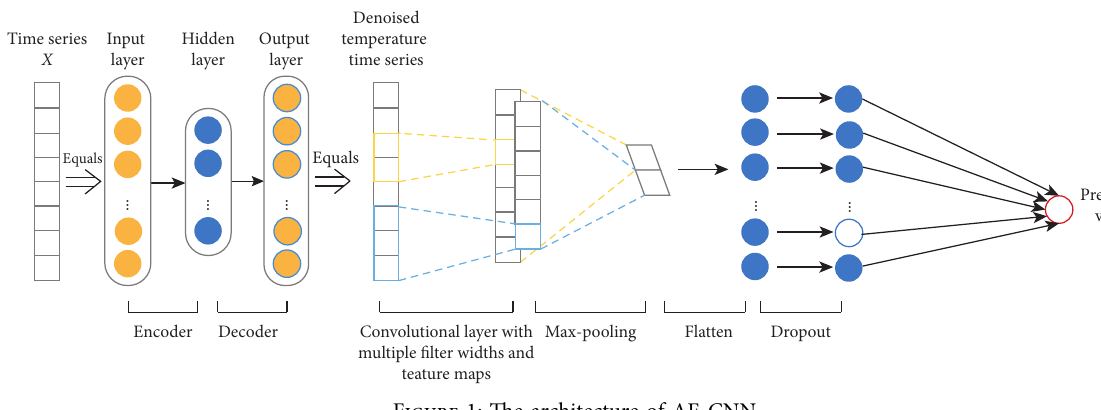
Figure 1: The architecture of AE-CNN.